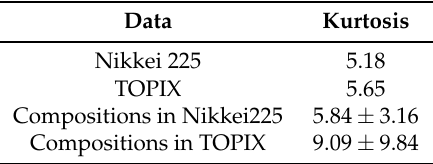
Table 2. Kurtosis of daily price changes in Japanese